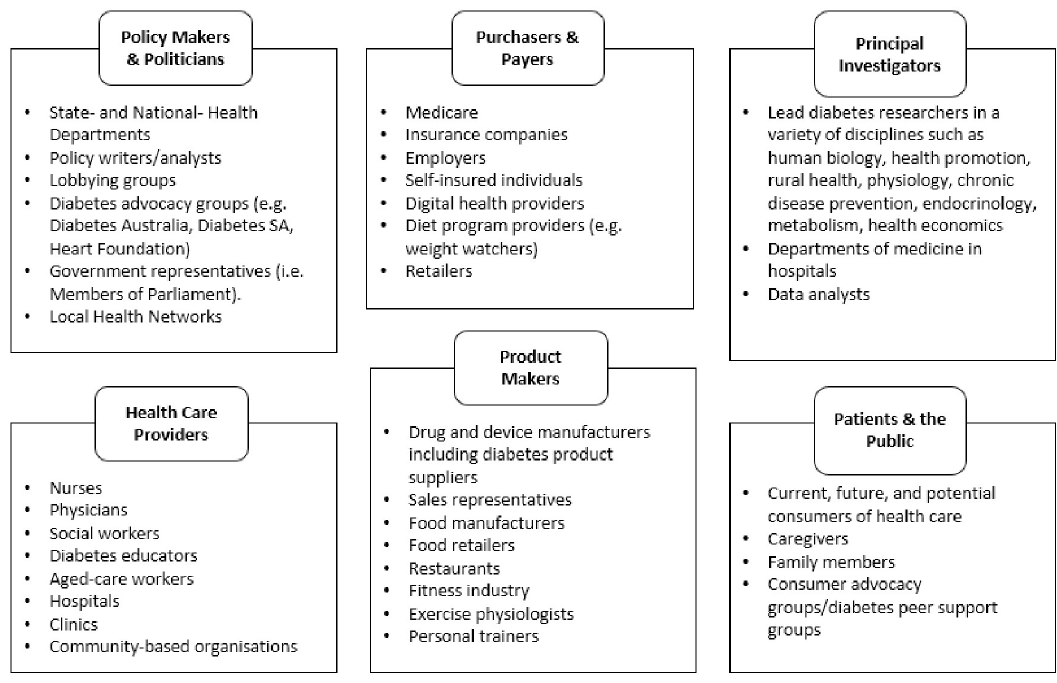
Fig 1. Stakeholder map including examples of key individual or organisation stakeholder